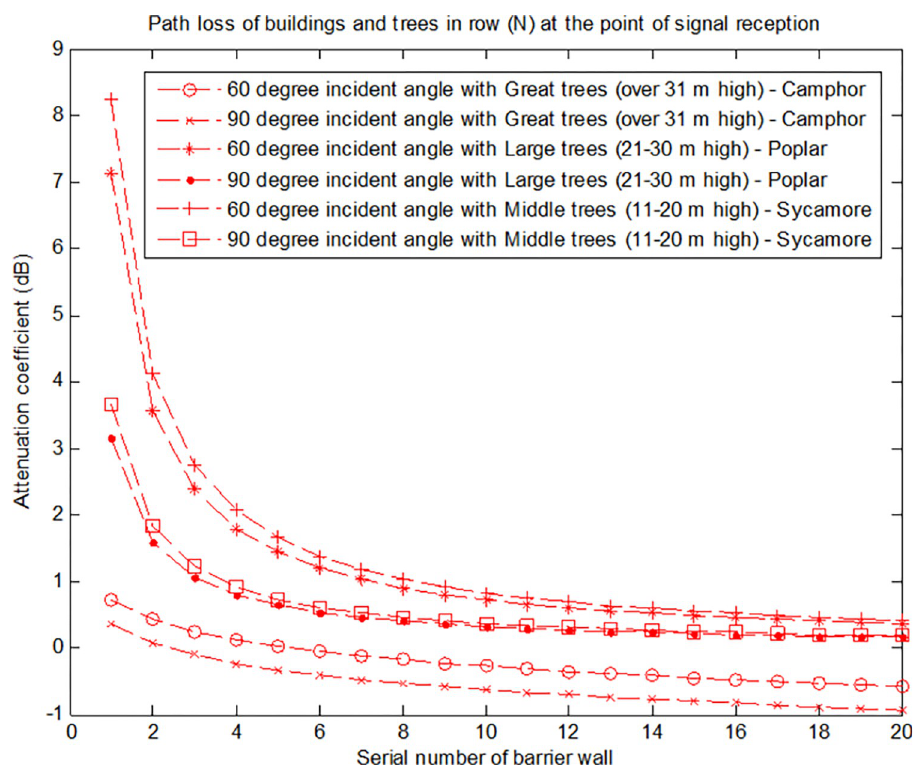
Fig 14. Path gain of buildings and trees in row N at a signal receiving station (varying with angle).